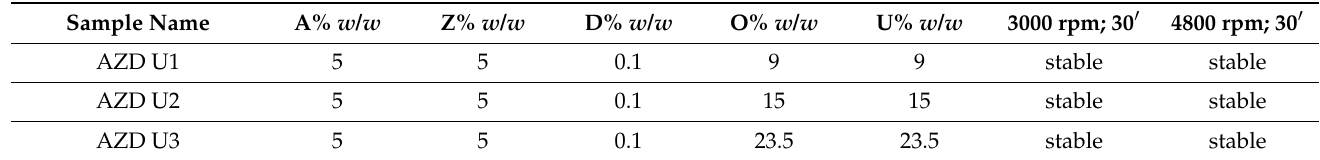
Table 9. Stability test results of emulsions formulated with Zea mays starch A and zinc oxide Z (total solid phase at 10% w / w ), diutan gum D at 0.1% w / w , and increasing concentration of oily phase O and a mixture sunscreen filters U (9–15–23.5% w / w ).